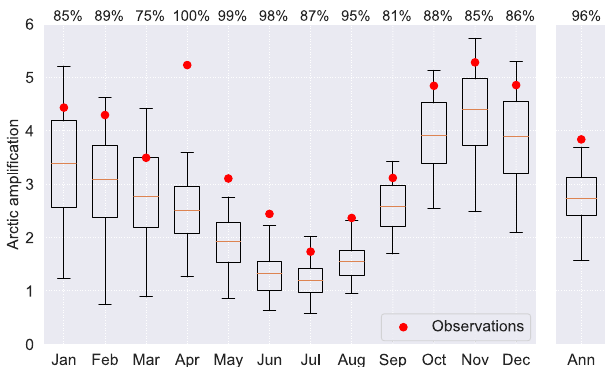
Fig. 5 Seasonality of the 43-year (1979 – 2021) Arctic ampli fi cation ratio. The red circles indicate the observed AA, as derived from the average of the four observational datasets. The orange lines indicate the medians of CMIP6 realizations, boxes show the fi rst and third quartiles, and whiskers extend to the 5 – 95th percentiles of the realizations. The numbers in the upper row give the percent rank of the observed AA in the CMIP6 ensemble distribution. The Arctic is de fi ned as the area north of 66.5 ∘